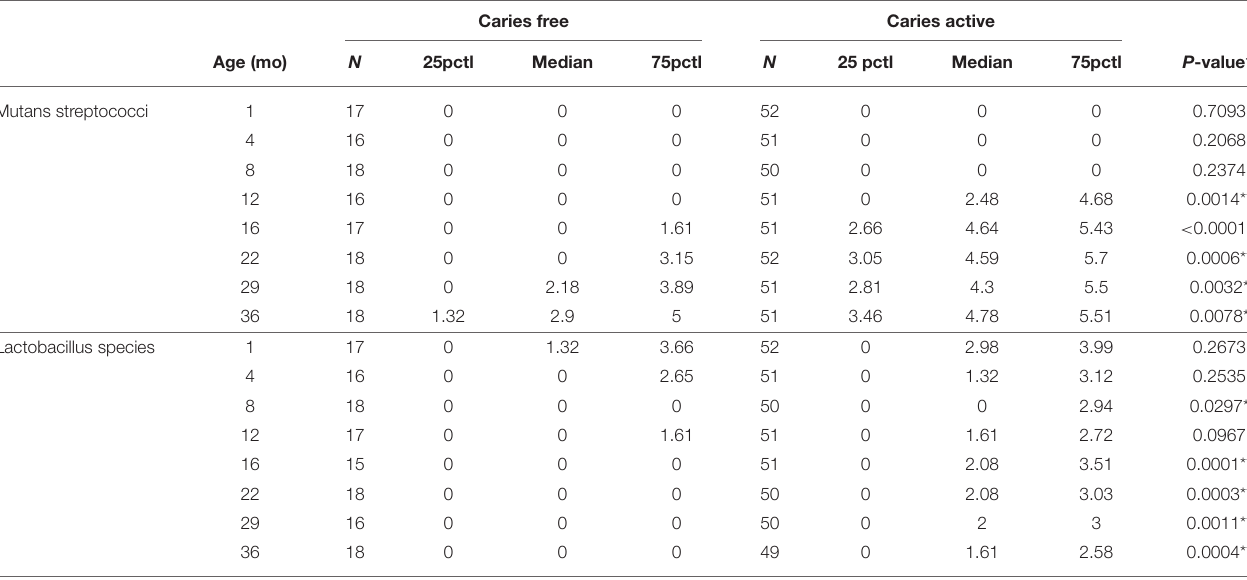
TABLE 2 | Two-group comparison of distribution of Log transformed mutans streptococci and Lactobacillus counts by visit (base 10 logarithm of [CFU/ml + 1]). Caries